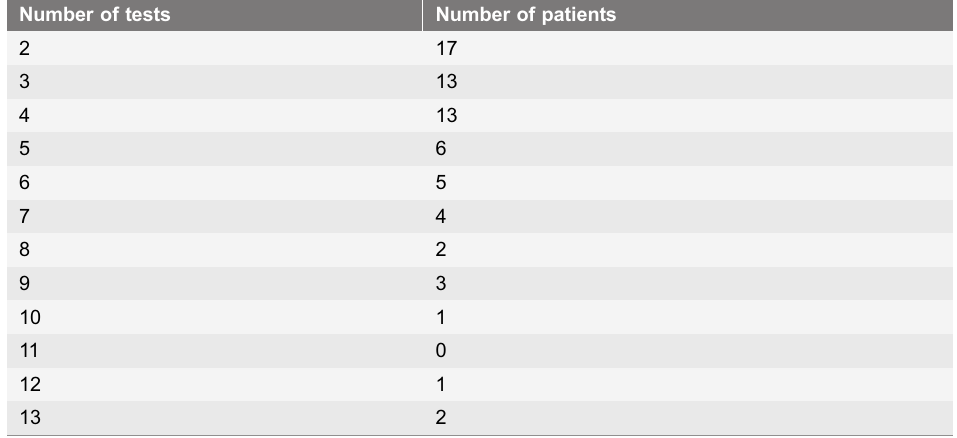
Table 2. Distribution of number of AChR-antibody measurements with a corresponding MGFA-score in 67 patients 1983–2013.